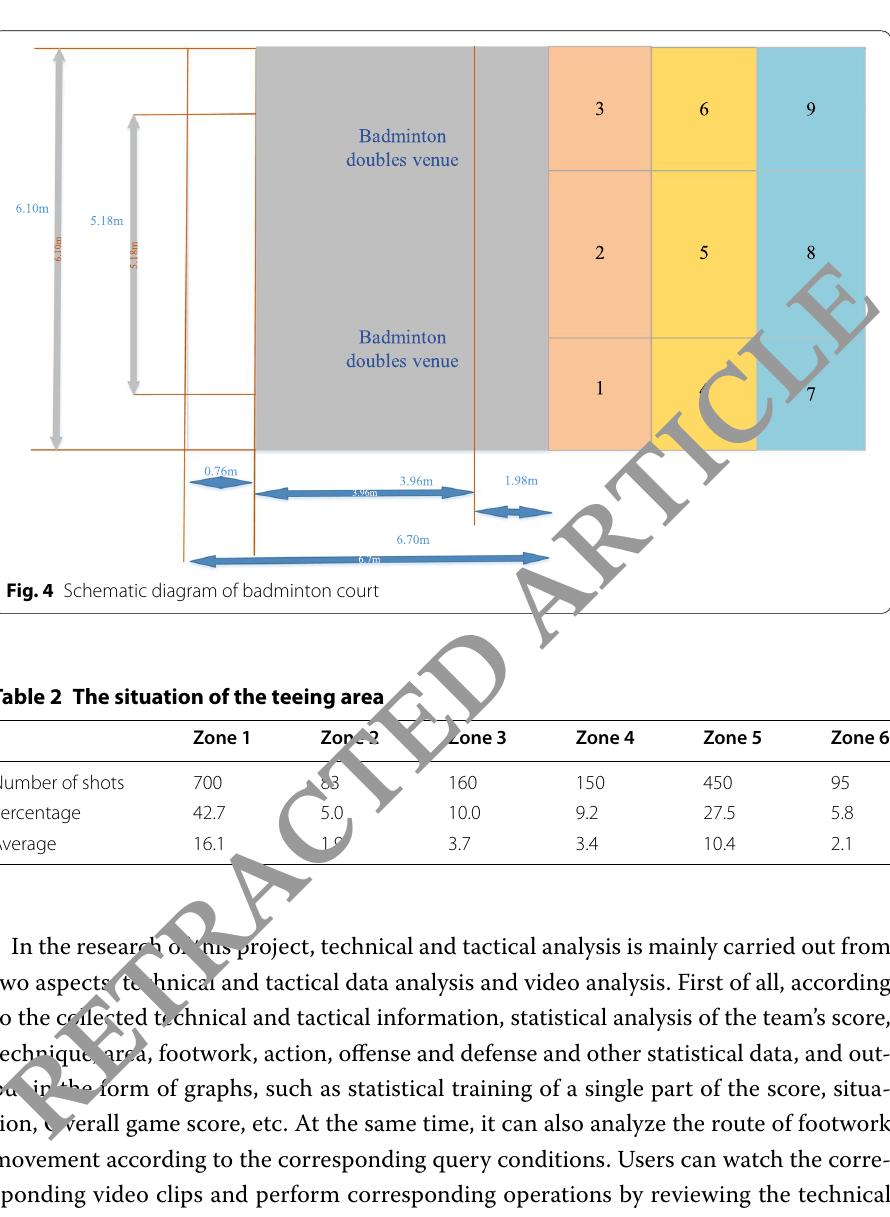
Fig. 4 Schematic diagram of badminton court